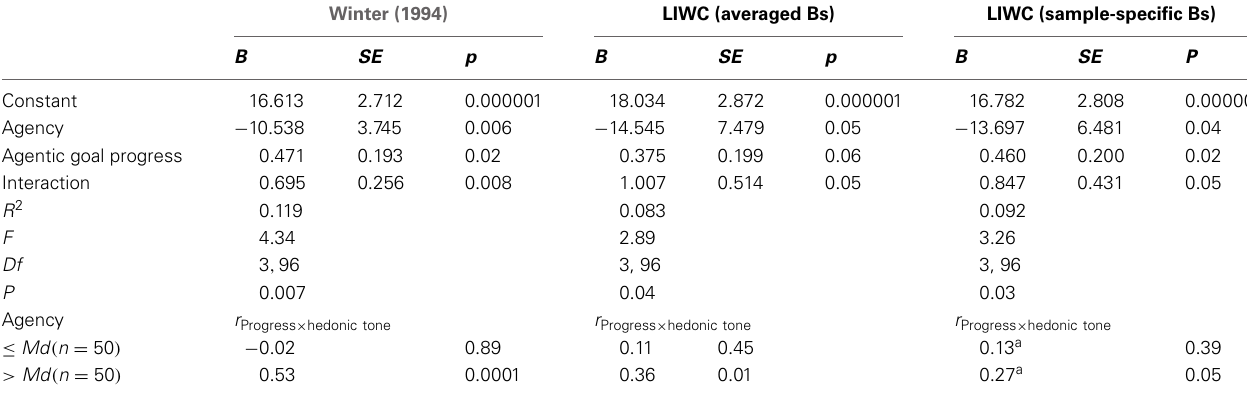
Table 7 | Comparison of criterion validity of PSE scores based on Winter’s (1994) coding system and scores derived from weighted LIWC dictionary scores in the German